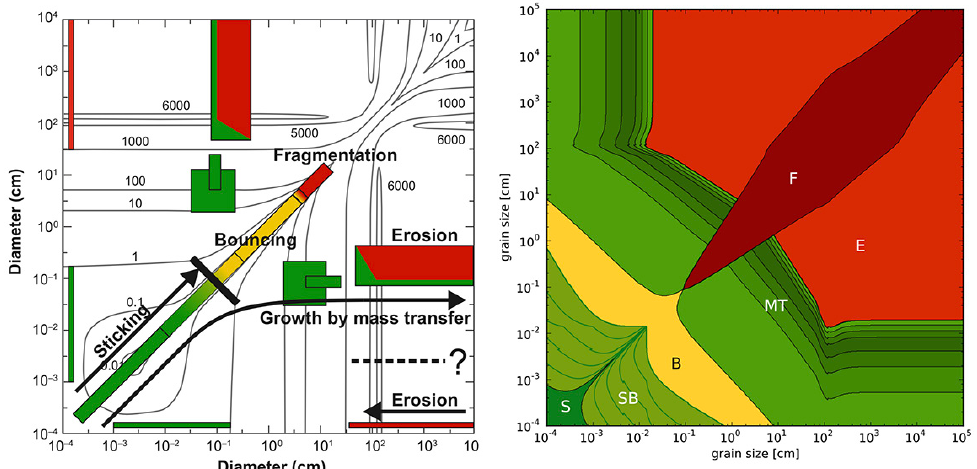
Figure 8. Schematic representation of the outcomes of dust collisions in protoplanetary disks. From [59], reprinted by permission. Left panel : the collision velocities (cm/s) between two dust agglomerates with sizes indicated on the axes in a minimum-mass solar nebula model at 1 AU [60]. The colored boxes denote the explored parameter space and results of laboratory experiments. Green represents sticking or mass transfer, yellow bouncing, and red fragmentation or erosion. “Sticking” growth [61] is prevented by bouncing. A possible direct path to the formation of planetesimals is indicated by the arrow “Growth by mass transfer”. Right panel : the parameter space for collisions outcomes between bare silicates grains used by numerical models of dust evolution [62].